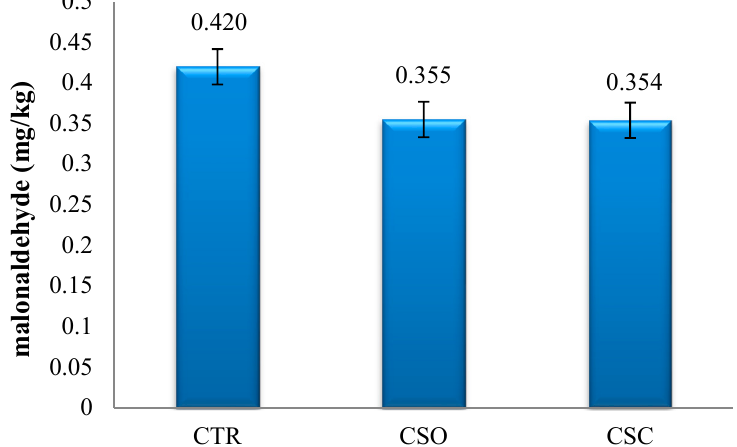
Figure 1. Malonaldehyde content (mg / kg of sample) in the breast muscles ( Pectoralis major ) of broiler chickens fed with rapeseed oil—CTR group, Camelina oil—CSO group, and Camelina expeller cake—CSC group.